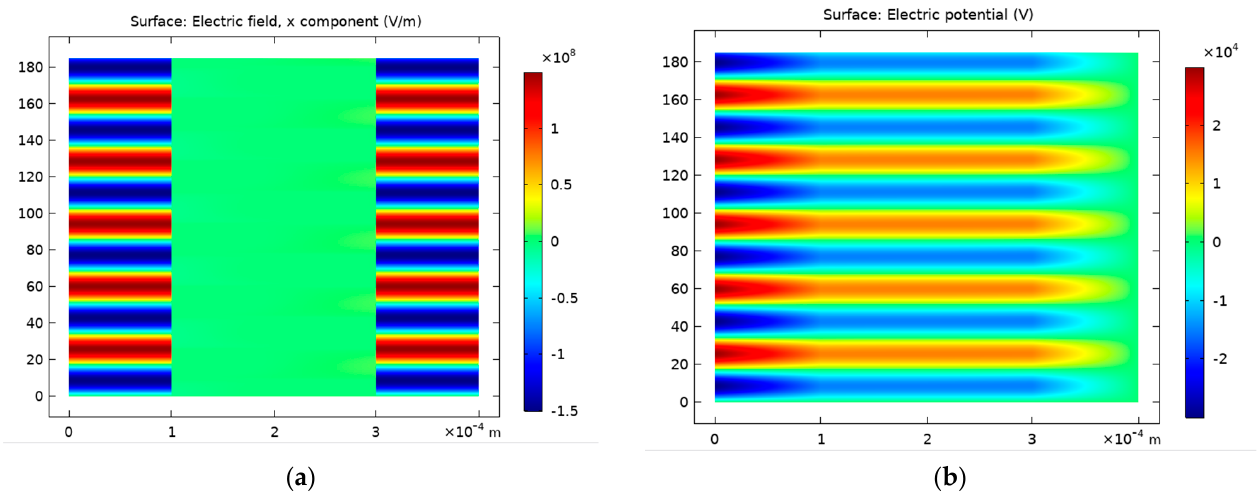
Figure 6. Spatiotemporal evolution of the electric field ( a ) and potential ( b ) in the interelectrode gap.